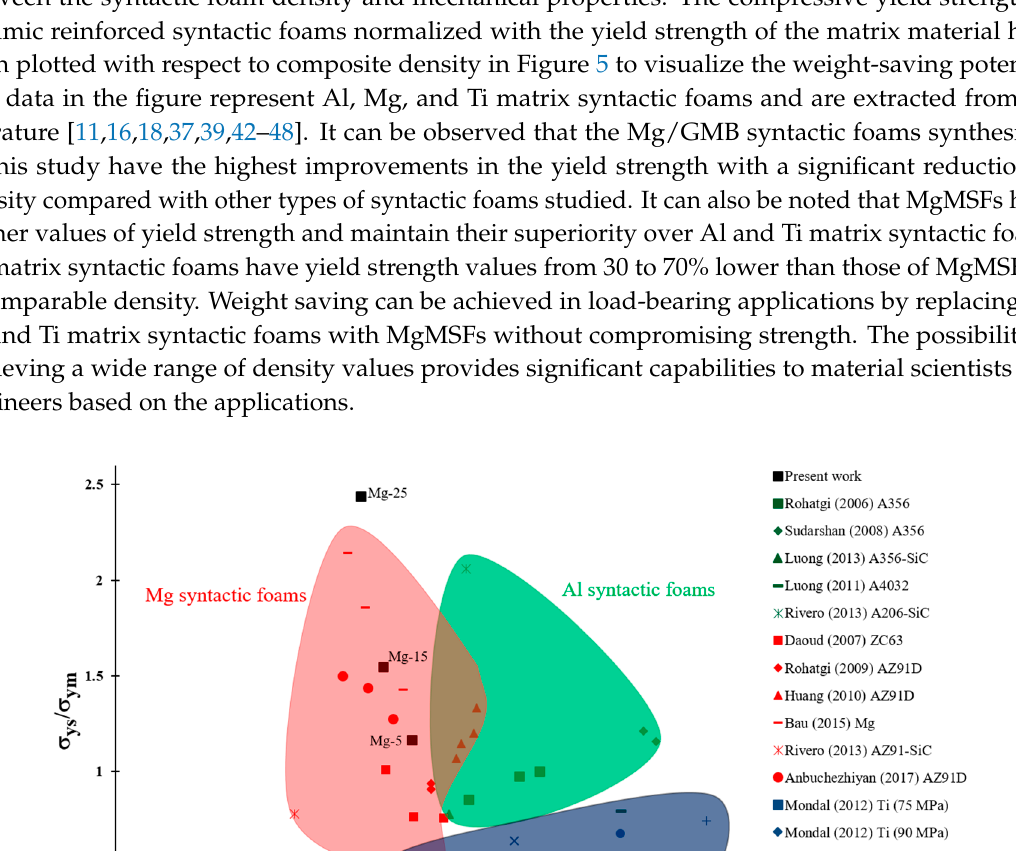
Table 3. Elastic modulus measurements of Mg and their syntactic foams along with comparison of biomechanical properties.